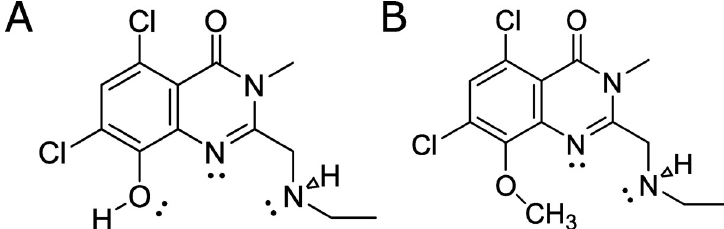
Fig 1. PBT434 and O-Methyl PBT434. ( A ) PBT434, 5,7-dichloro-2-((ethylamino)methyl)-8-hydroxy- 3-methylquinazolin-4(3H)-one. ( B ) PBT434-met, the 8-methoxy, non-chelating derivative of PBT434. PBT434 forms a bis-complex with both Fe 2+ and Fe 3+